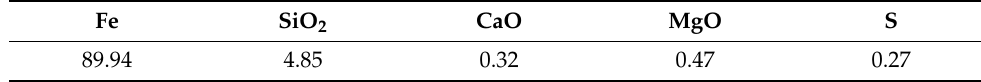
Table 4. The main chemical composition of magnetic